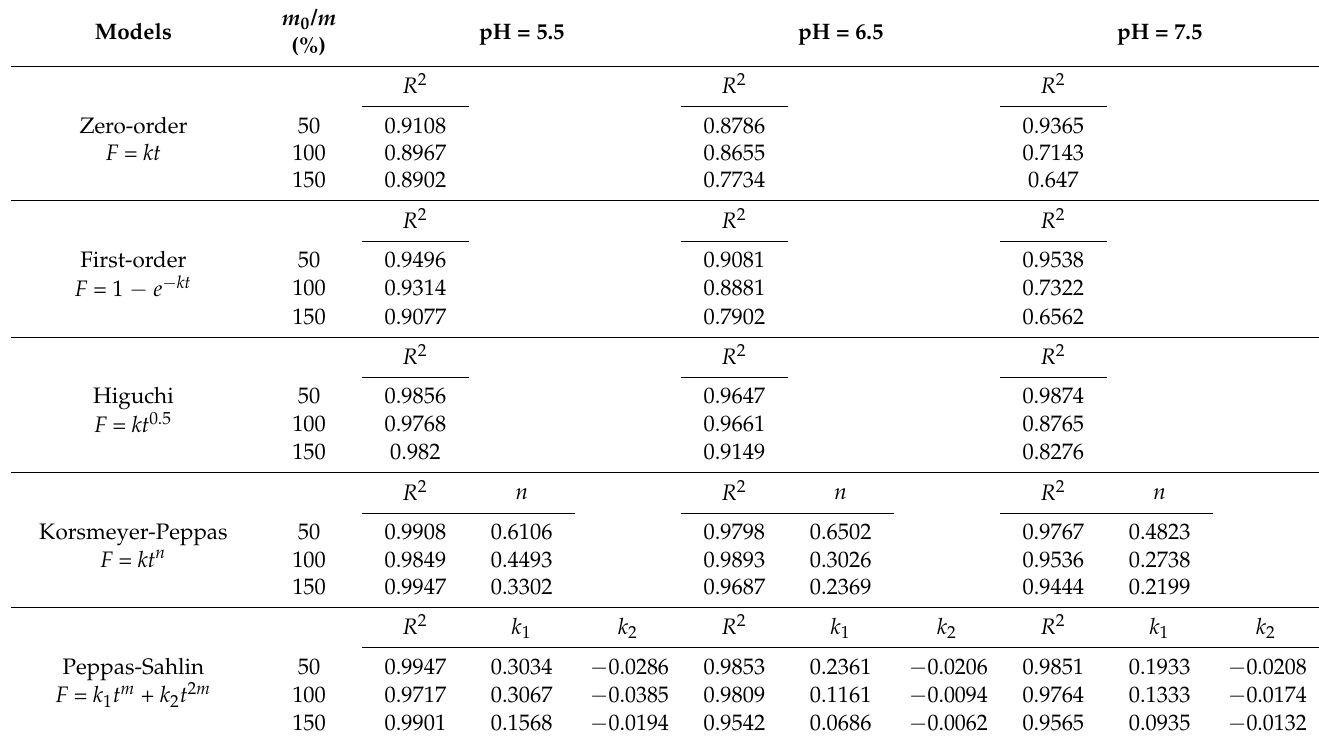
Table 4. Kinetic parameters of 5-FU release from MC/M/H-B4